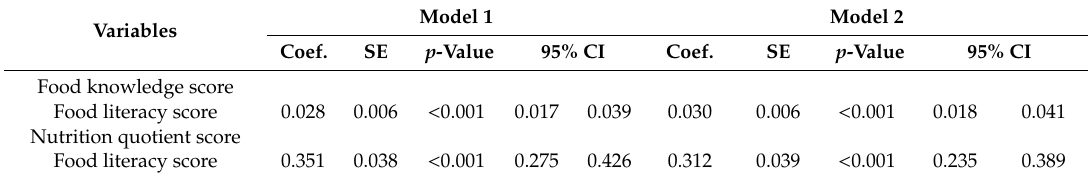
Table 6. Associations of food literacy scores with food knowledge and nutrition quotient scores (N = 200). Model 1 Model 2 Variables Coef. SE p -Value 95% CI